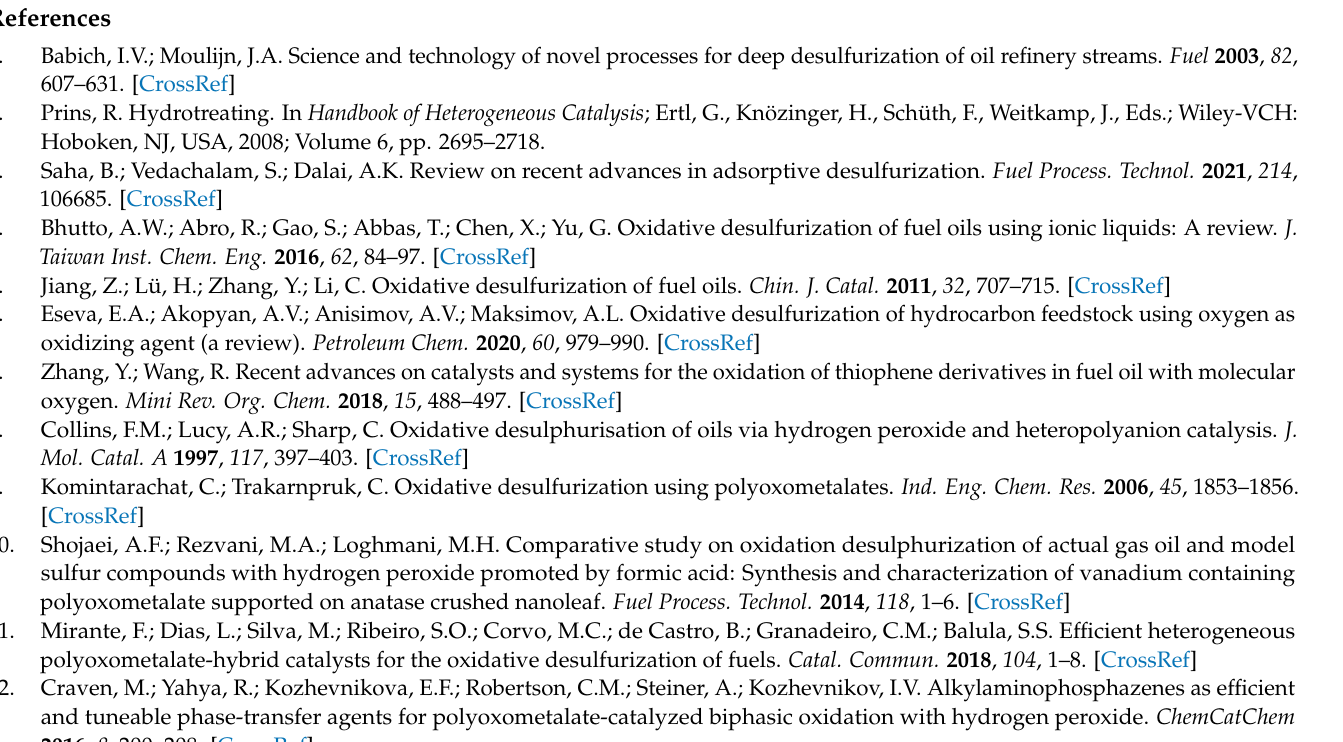
Figure S2. DRIFT spectra (in KBr): 15%HPA-1/SiO2 (1) and bulk HPA-1 (2). Bands at 476 and 1101 cm − 1 belong to silica support. The presence of bands at 786, 866 and 964 cm − 1 in spectrum (1) confirms that the Keggin structure of HPA-1 is intact in 15%HPA-1/SiO 2 ; Figure S3. DRIFT spectra (in KBr) of fresh and spent HPA-1 catalyst after 5 successive runs: fresh HPA-1 (1), spent HPA-1 catalyst after 5 successive runs (2) and DBT sulfone